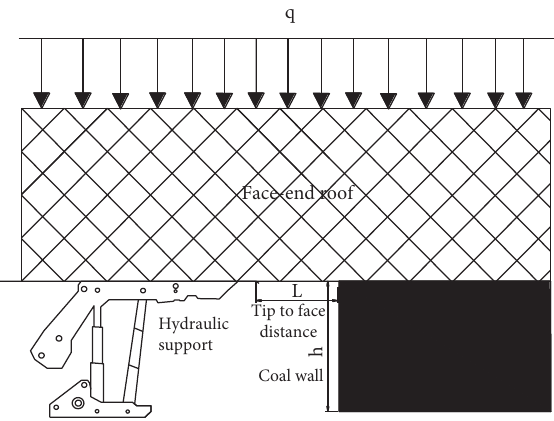
Figure 4: “Face-end roof-coal wall-support” model.